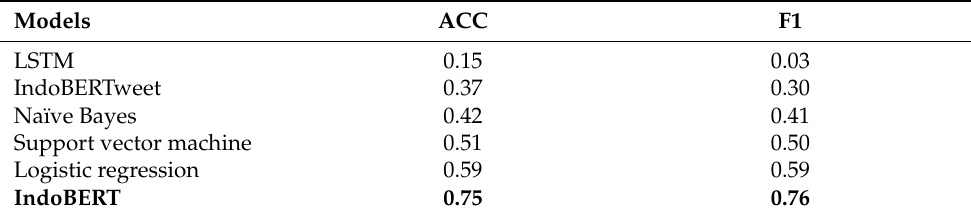
Figure 8. Location inference results at the user’s tweet level using IndoBERTweet. Each bar on the x-axis represents the user in the test data, while the y-axis represents the percentage of the user’s tweet prediction results. Table 3. Location prediction results using user tweets by tweets aggregation into one